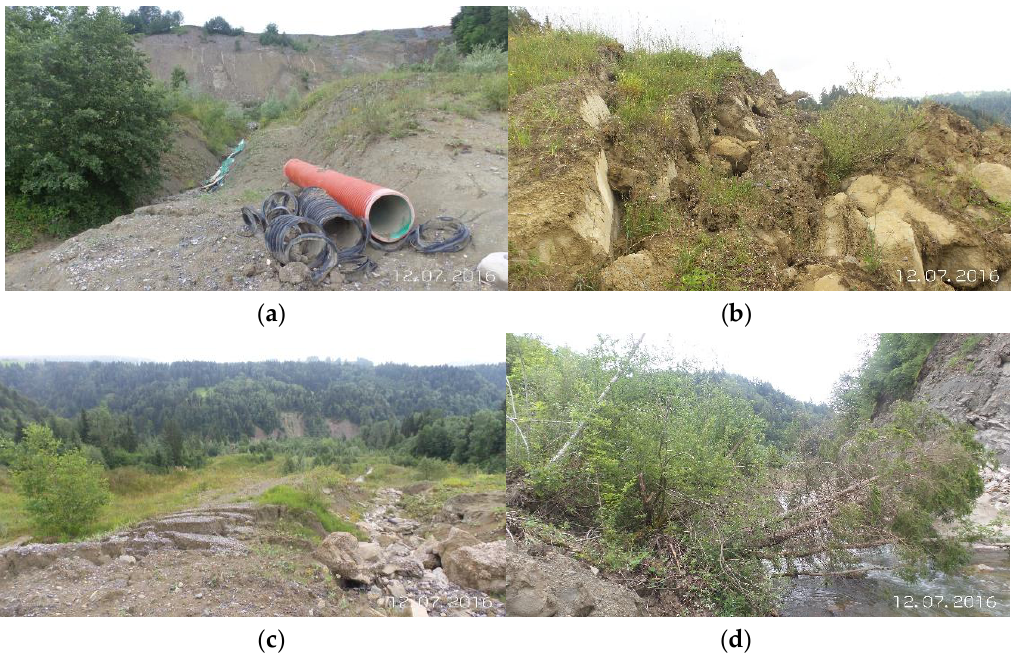
Figure 4. ( a ) View to upper landslide scar and drainage mitigation; ( b ) Mid-section, characterized by radial tension cracks; ( c ) Damage to infrastructure, caused by progressive slide-type failure; ( d ) Frontal lower toe section of the landslide near the Weißach River illustrating movement of the landslide from tilted, toppling trees.